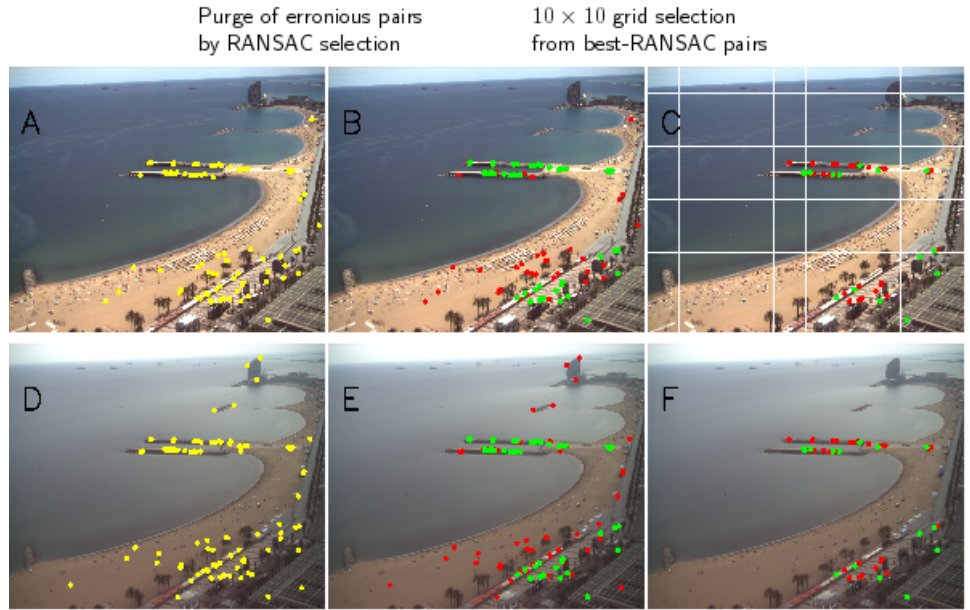
Figure 5. Illustration of the step 3. Pixels in the image to calibrate ( A – C ) and in the first image of the basis ( D – F ): the K 0 original pixels from matching algorithms ( A , D ), RANSAC selection ( B , E , with K 1 green points), grid selection out of the RANSAC points ( C , F , with K green